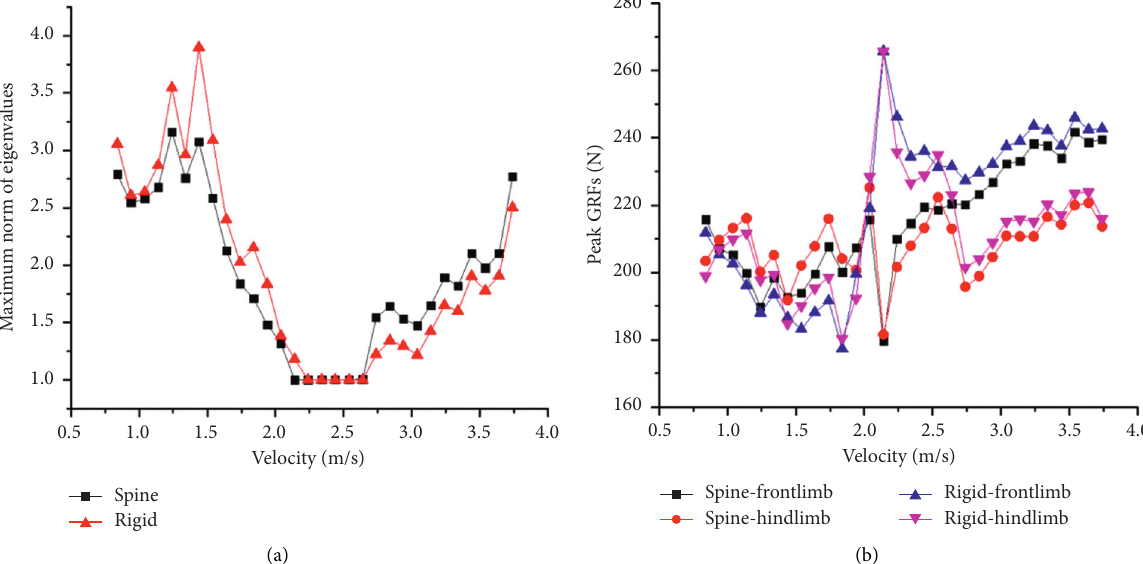
Figure 8: Eigenvalue and GRFS of model with and without spine at different velocities. (a) Maximum magnitude of the eigenvalues, and (b) peak ground reaction forces of forelimb and hindlimb.